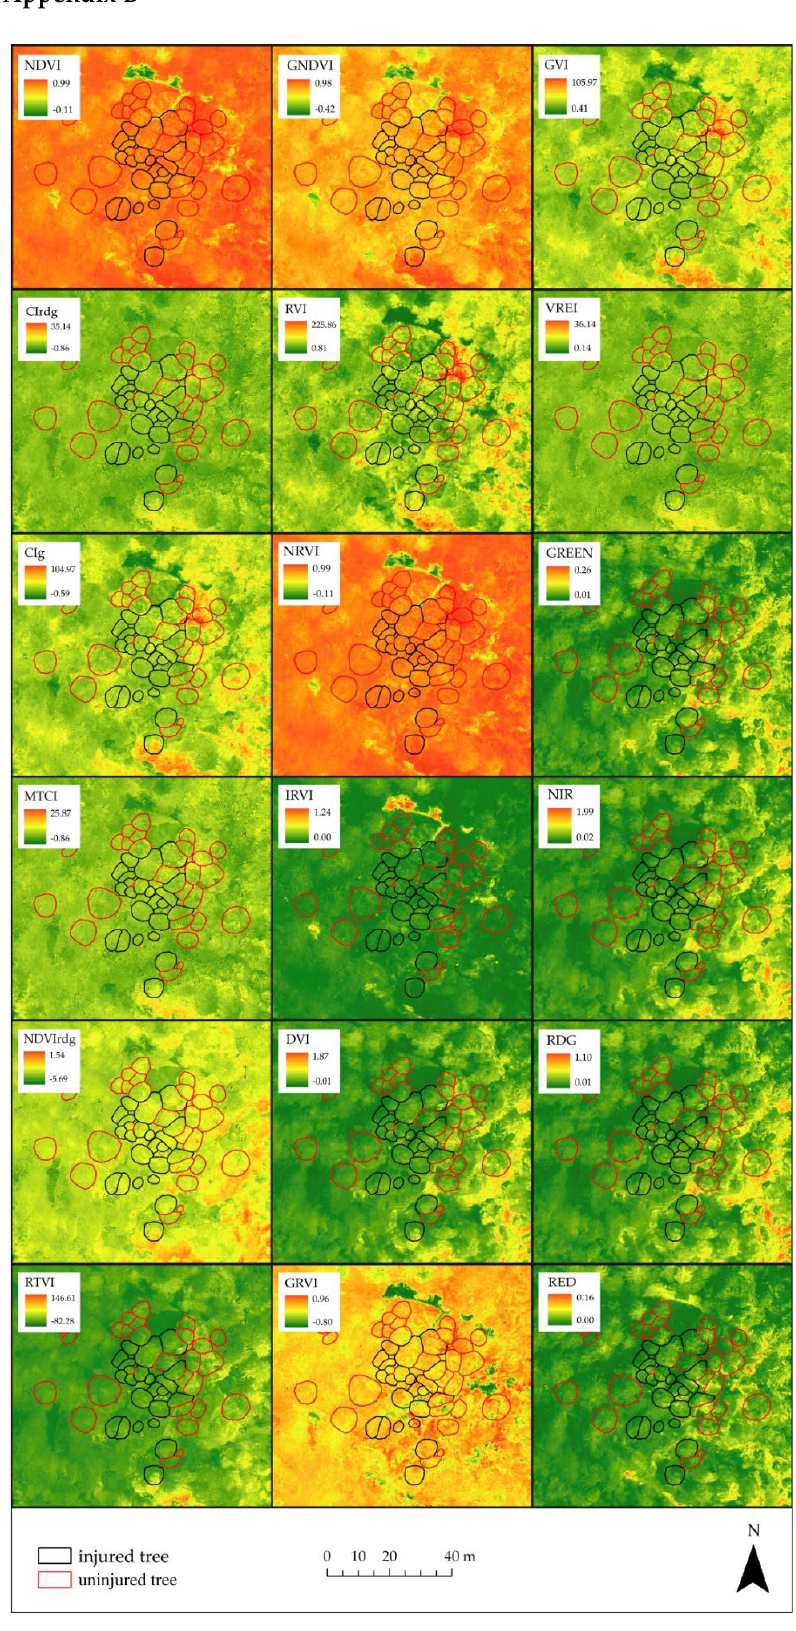
Figure A1. The maps of all vegetation indices (VIs) and individual spectral bands for the Jelovica site (16 August 2019).